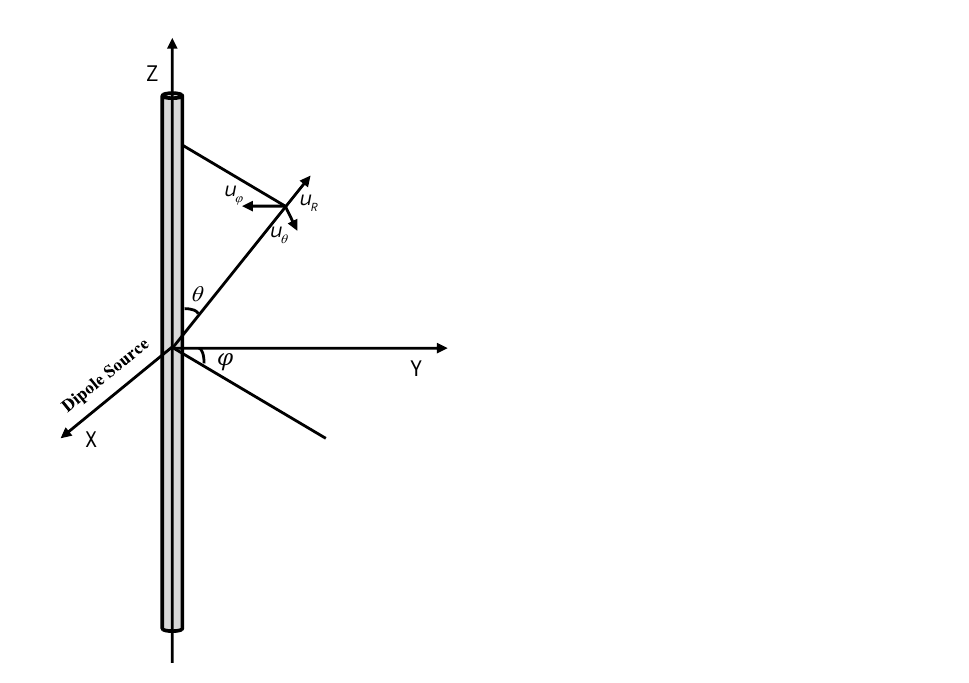
Figure 1. Coordinate system for the radiation analysis of a dipole source in a fluid-filled borehole.